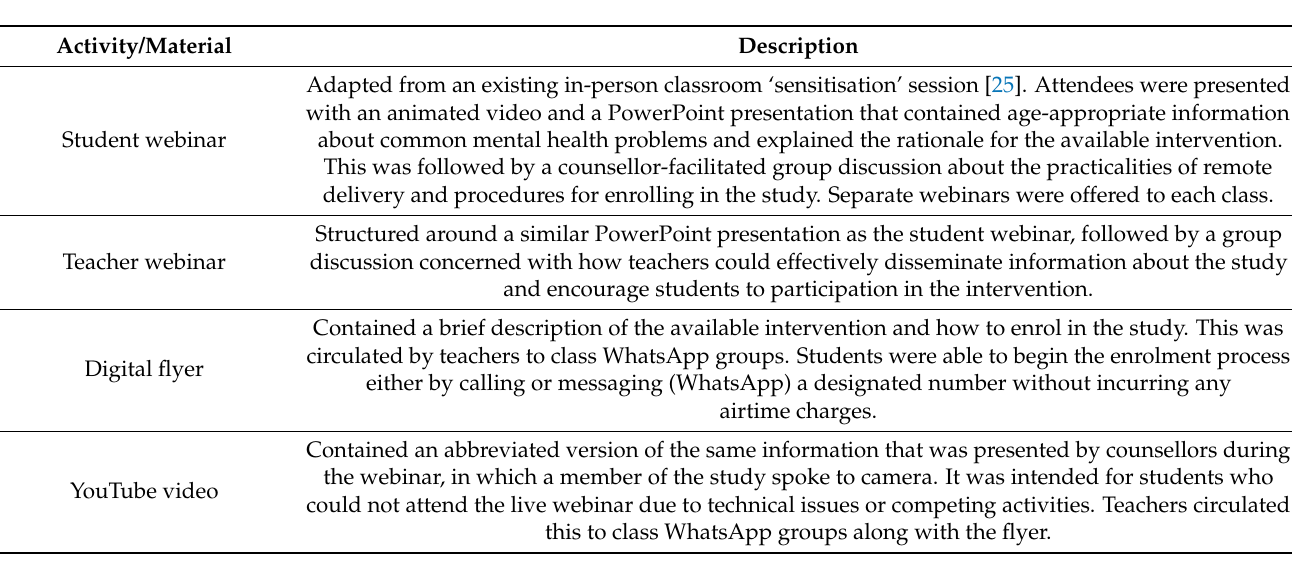
Table 1. Recruitment activities and